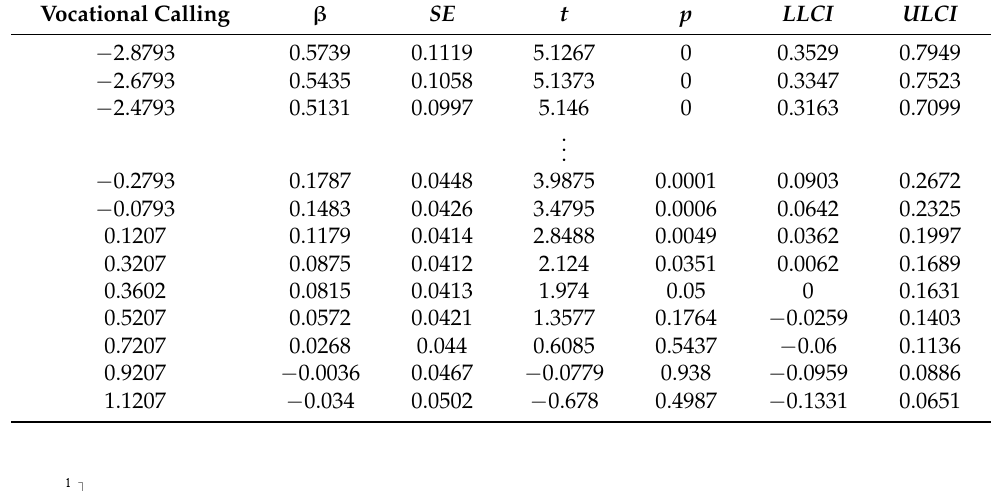
Table 7. Conditional effect significance area of self-efficacy according to vocational calling.